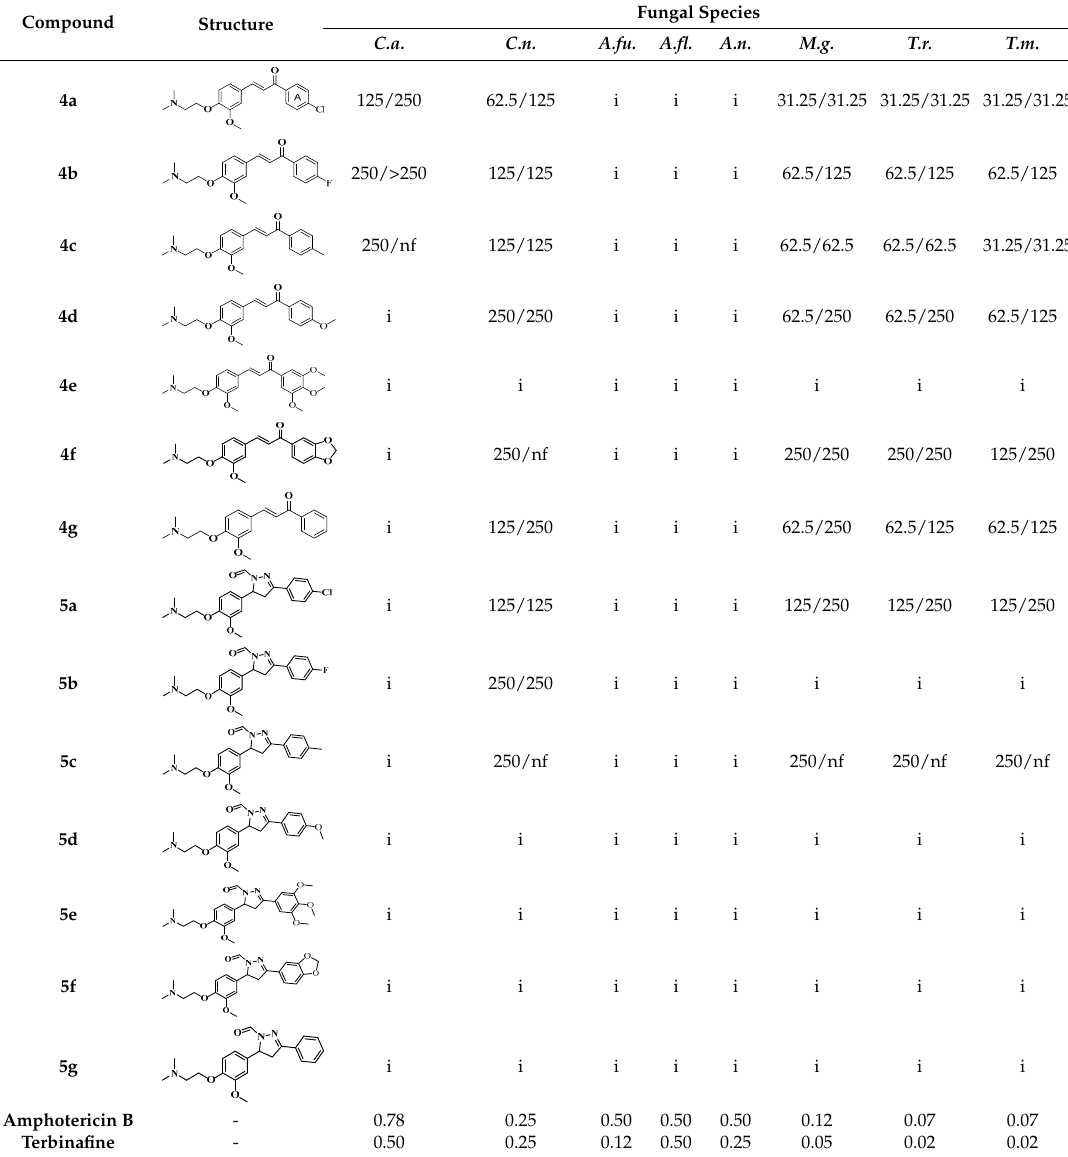
Table 1. Minimum inhibitory concentration and minimum fungicidal concentration of compounds 4a – g and 5a – g (MIC/MFC in µg/mL).